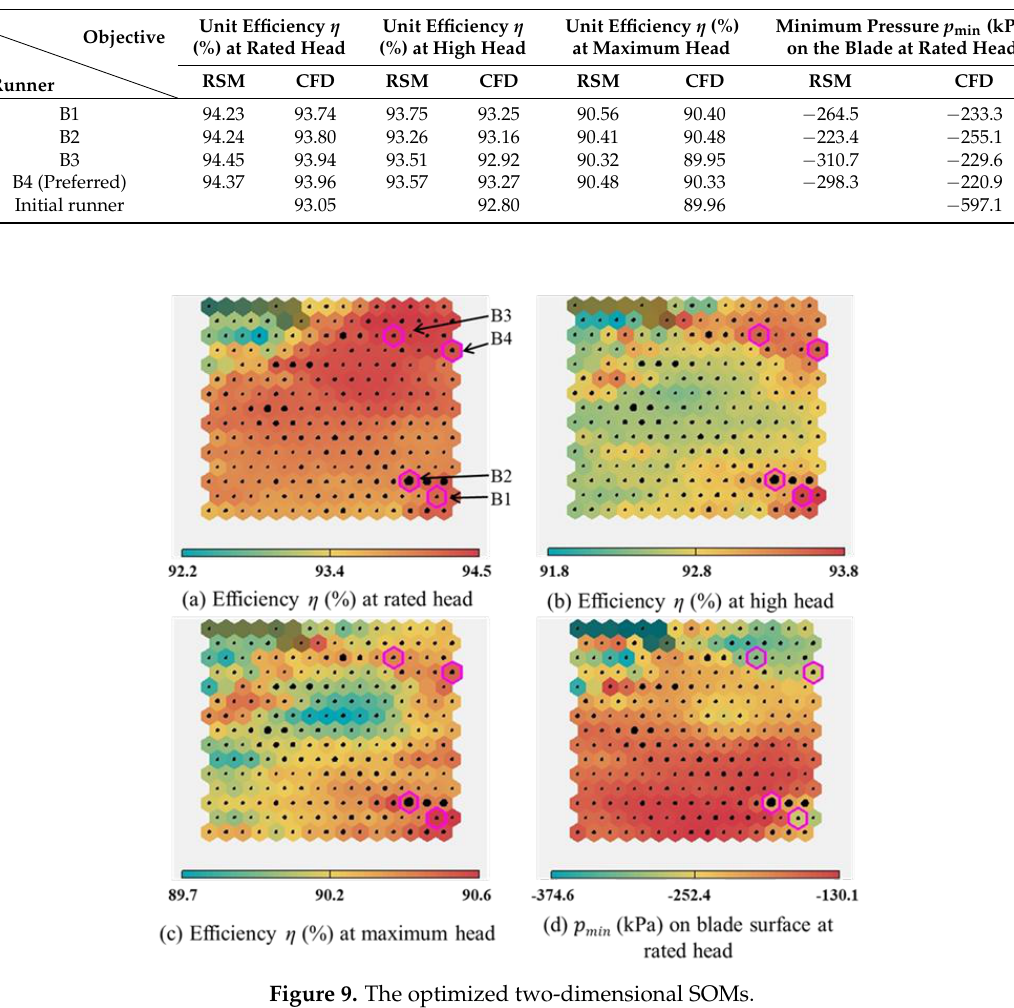
Table 7. Results in the second step optimization. Table 5. Results in the first step optimization.